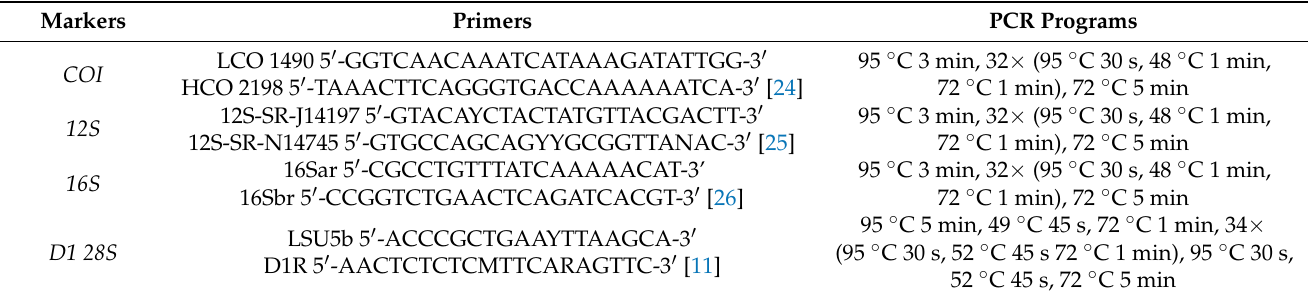
Table 2. Primers and thermal cycling conditions for the PCR reactions of the COI , 12S , 16S , D1 28S , and 18S-ITS1 sequences in this